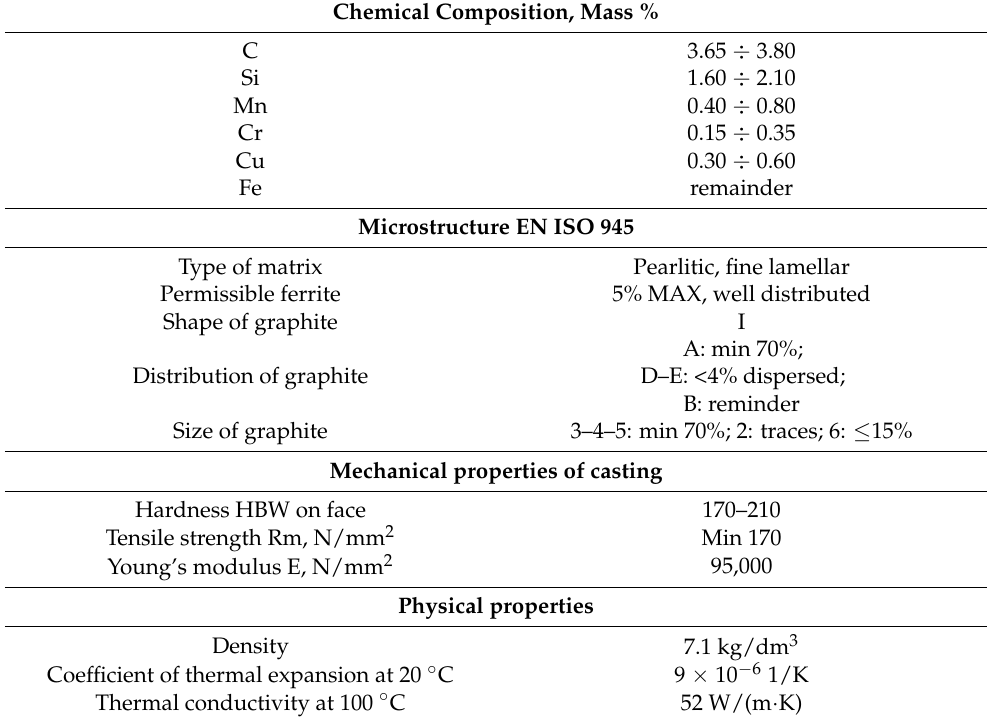
Table 1. Material